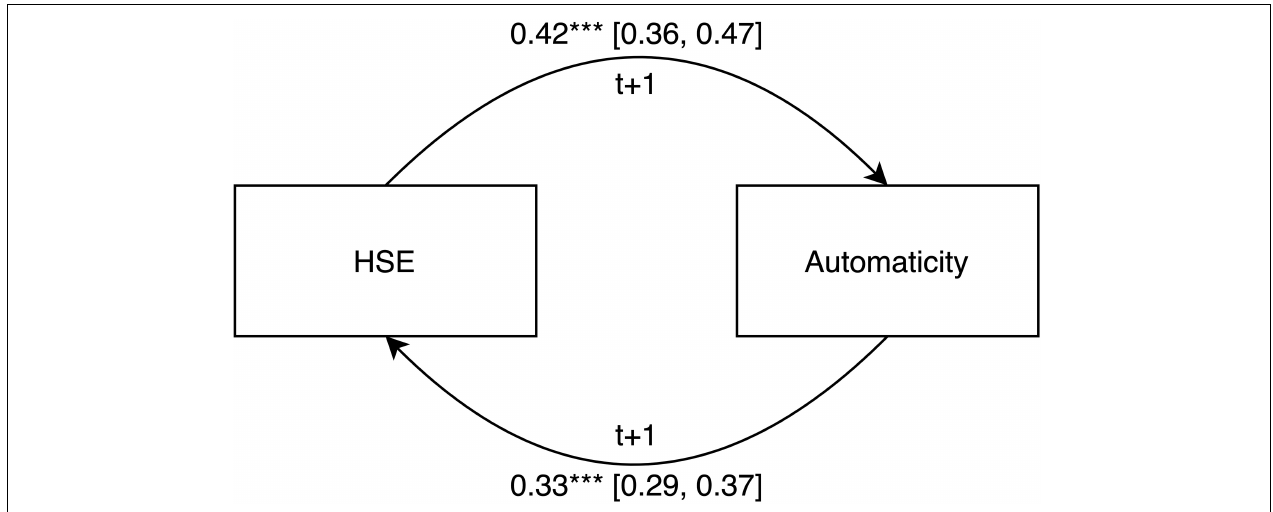
FIGURE 1 | Virtuous cycle of automaticity and habit self-efficacy. Note. Virtuous cycle of habit self-efficacy (HSE) and automaticity with HSE at time t predicting automaticity at t + 1 and automaticity at t predicting HSE at t + 1. 95% confidence intervals are in brackets. *** p < 0.001.